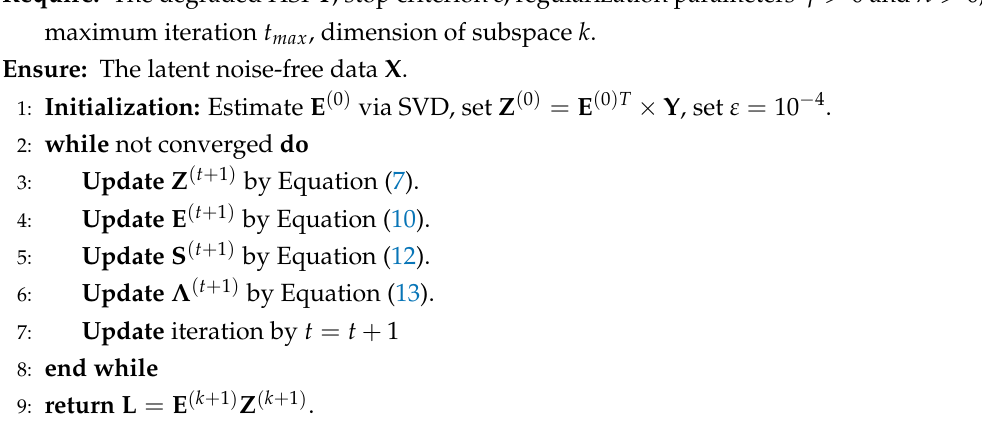
Algorithm 1 Optimization procedure for solving Model